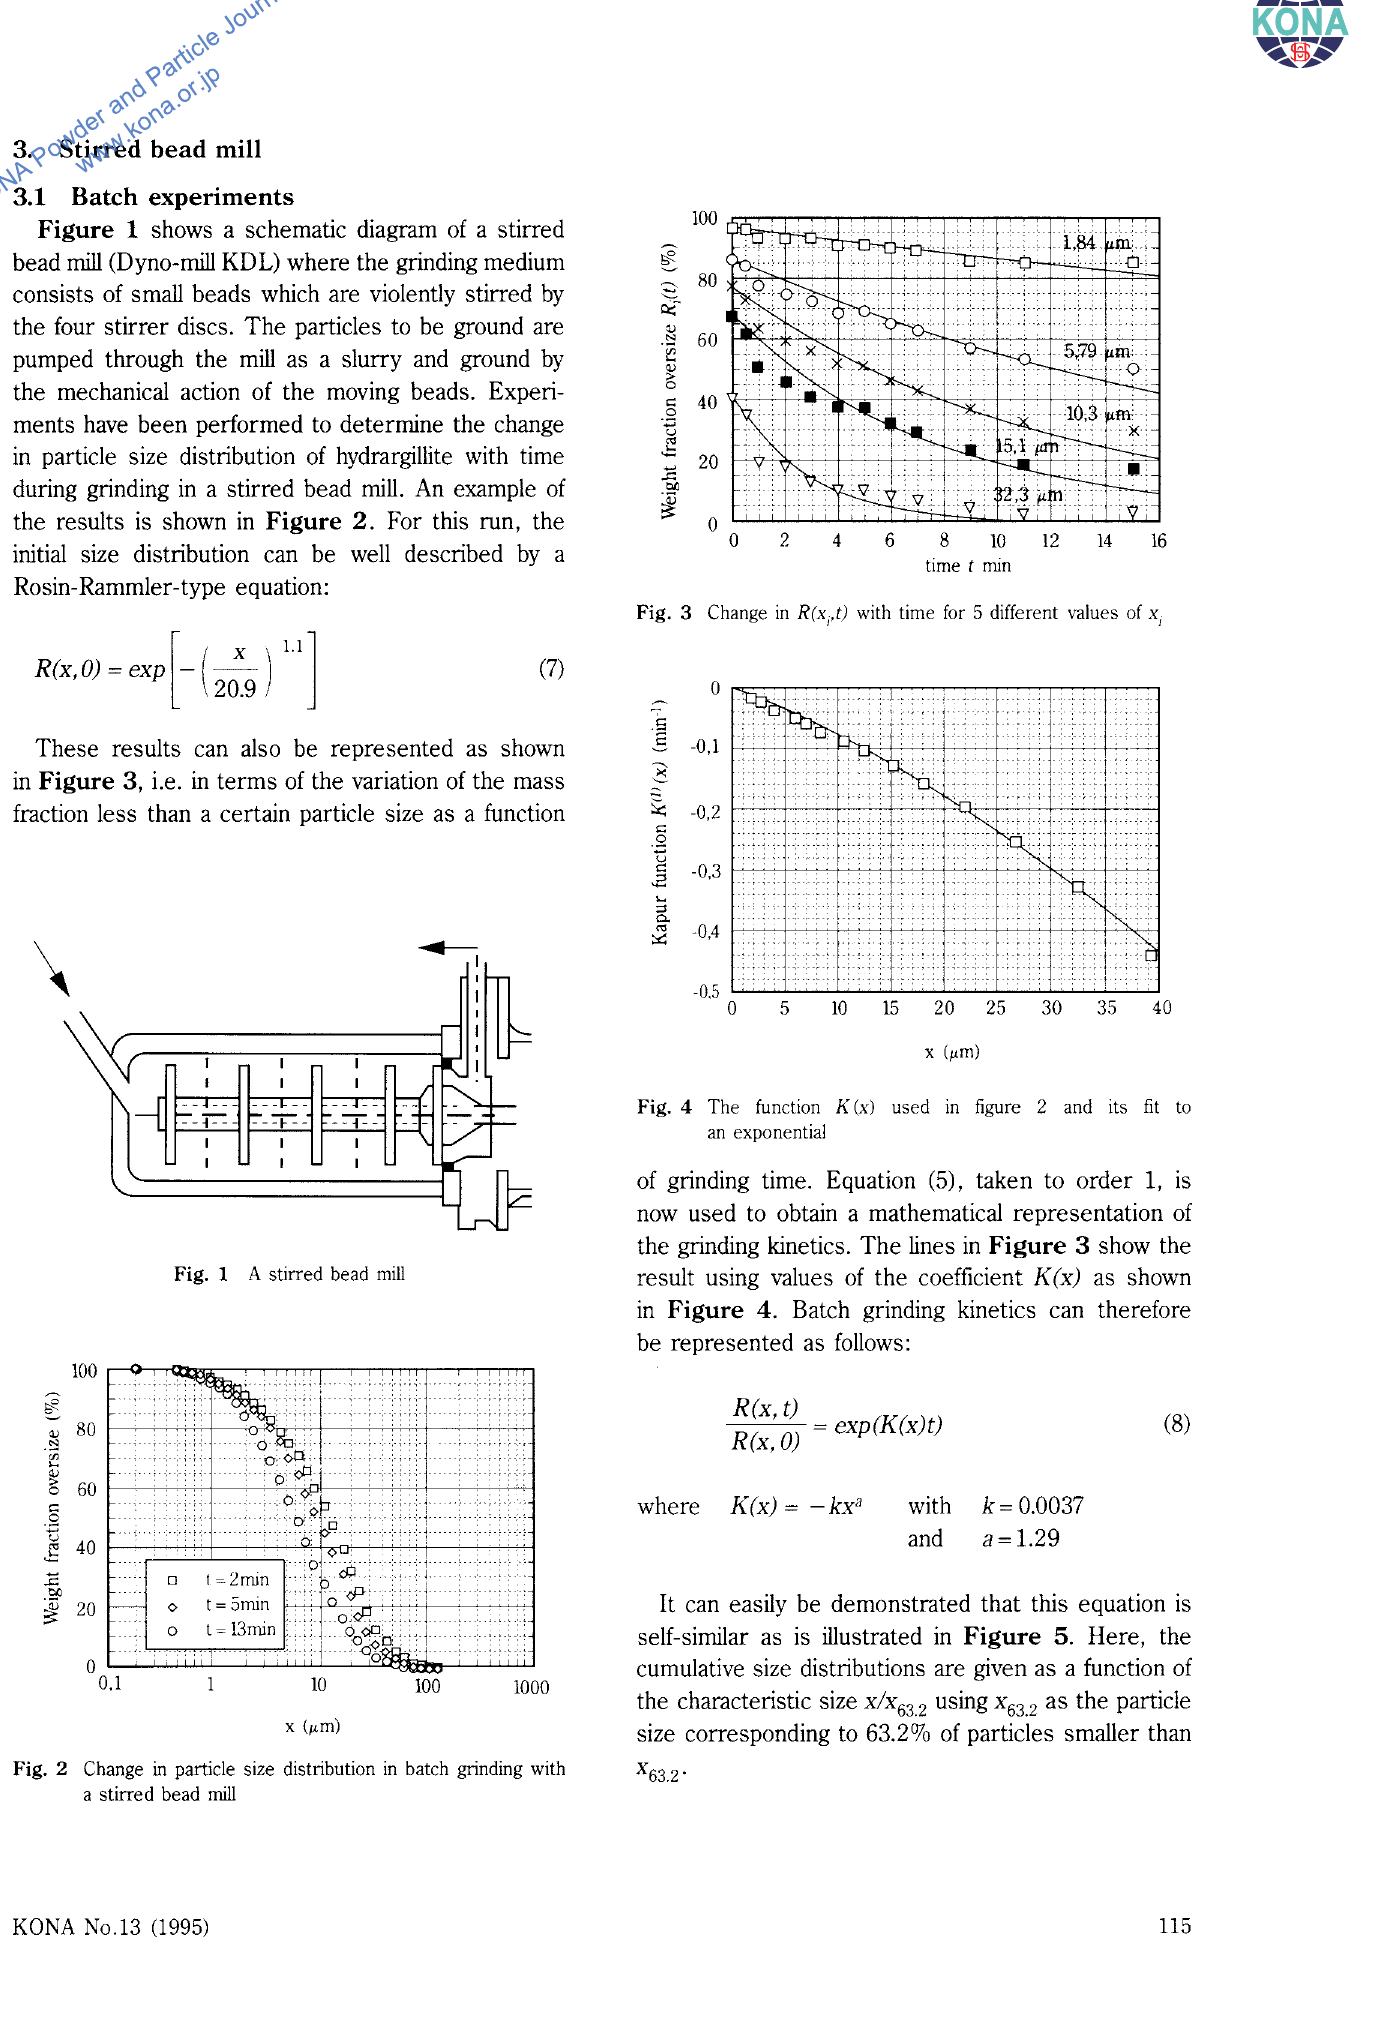
Fig. 3 Change in R(x/) with time for 5 different values of X